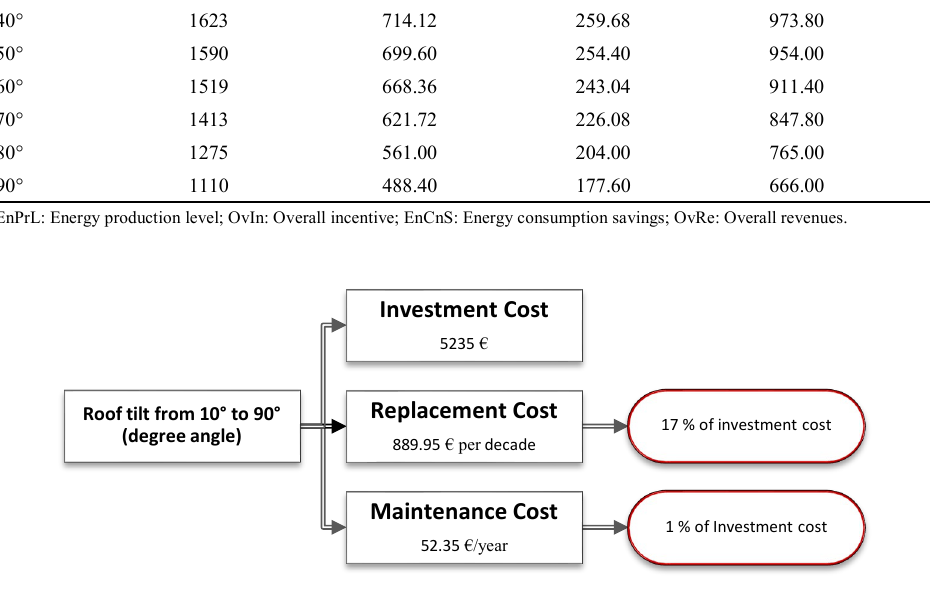
Fig. 3. Investment Cost, Replacement Cost and Maintenance Cost for all the different